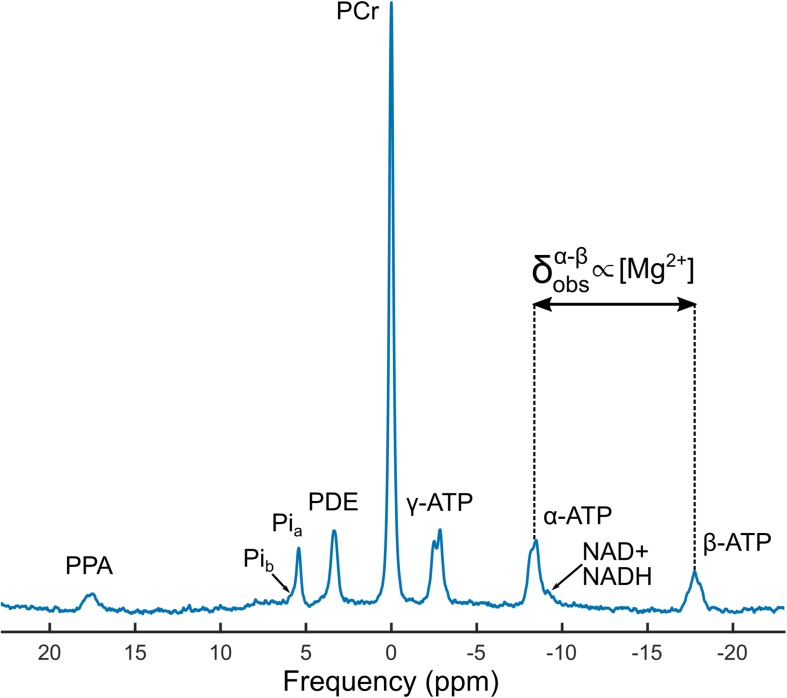
A representative phosphorus magnetic resonance spectroscopy (31P-MRS) spectrum from a 48-year-old male participant. The concentration of intramuscular ionized magnesium, [Mg2+], was determined using the observed chemical shift difference between the alpha and beta adenosine triphosphate (ATP) peaks, δobsα-β, along with the weighted pH calculated from the amplitudes and chemical shifts of inorganic phosphate peaks Pia and Pib. Also shown are spectral lines from phosphocreatine (PCr), phosphodiesters (PDEs), oxidized and reduced nicotinamide adenine dinucleotide (NAD+ and NADH, respectively), and an external reference peak from phenylphosphonic acid (PPA).